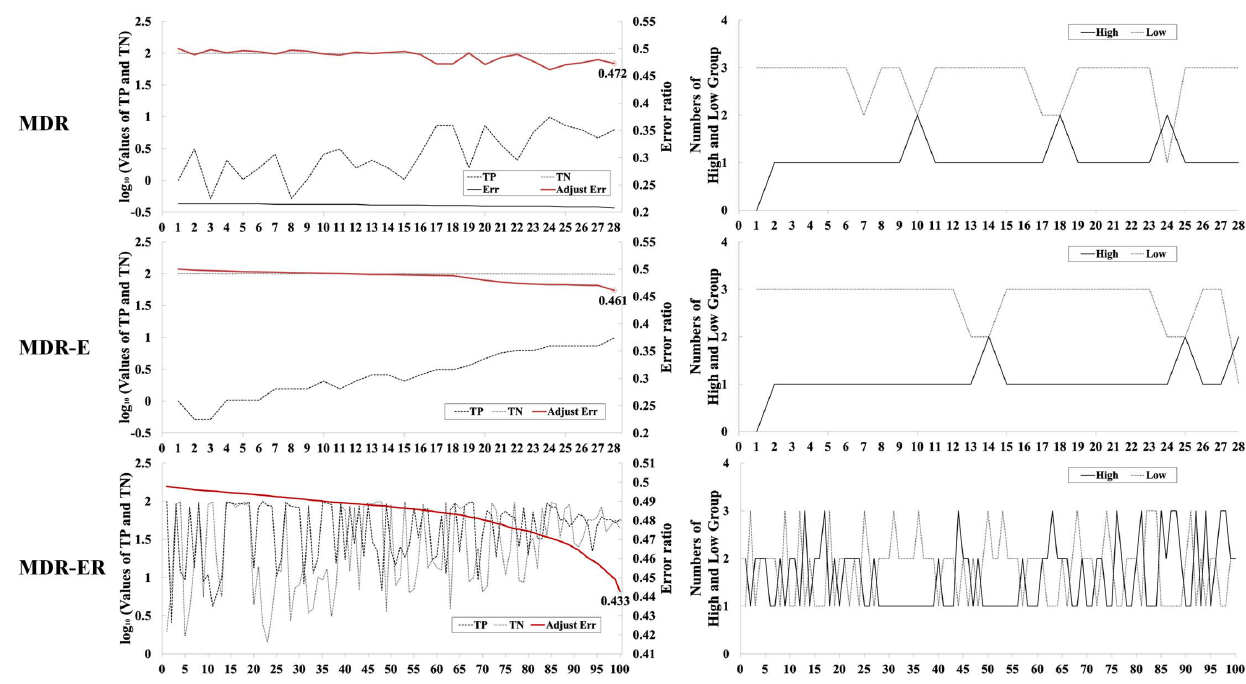
Figure 3. Frequency analysis of TP, TN, classification error, and numbers of high-risk and low-risk groups in 2-locus genotypes.